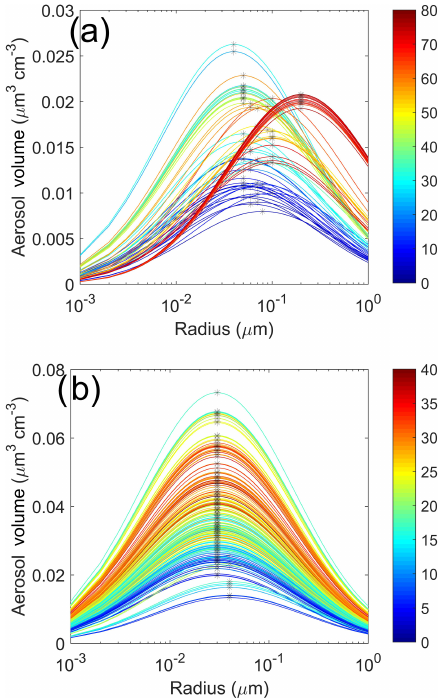
Figure 4. The variation in aerosol volume concentration distribu- tions in the enhanced aerosol layer with RHi for (a) case 5 (21 July), and (b) the other cases corresponding to the CI < 6 case (diamonds) in Fig. 3b. The color of each distribution represents RHi, indicated by the color bar. The asterisk is the mode radius of each